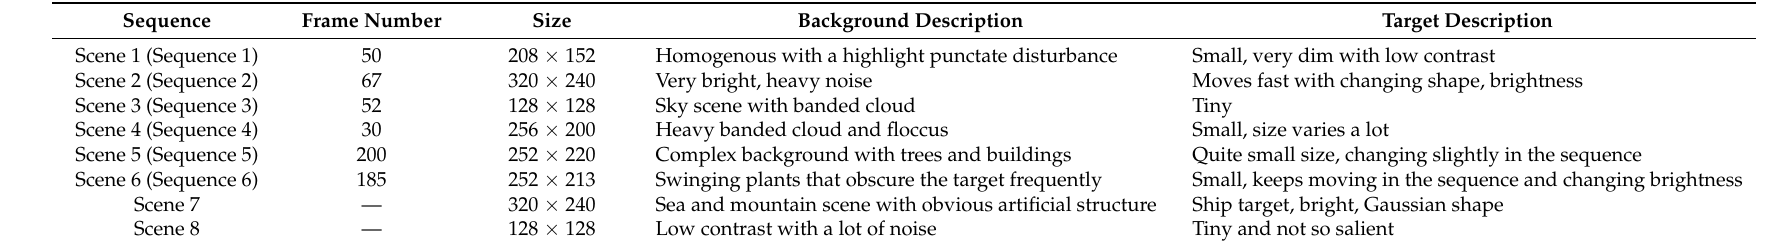
Table 2. Detailed description of the eight real scenes.